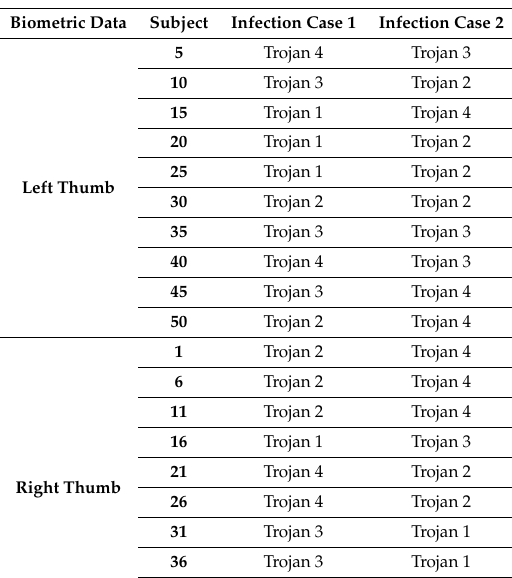
Table 1. The description of infecting the biometric